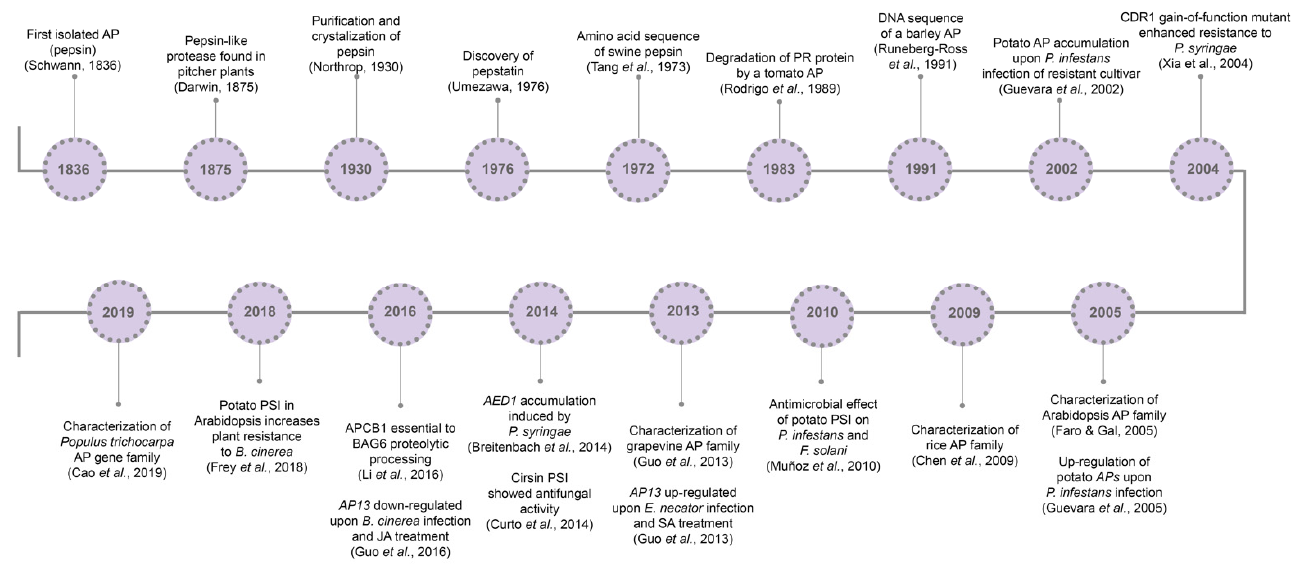
Figure 1. Aspartic proteases historical breakthroughs. AP, aspartic protease; CDR1, constitutive disease resistance 1; PSI, plant-specific insert; AP13, aspartic protease 13; SA, salicylic acid; AED1, apoplastic enhanced disease susceptibility 1; APCB1, aspartyl protease cleaving bcl-2 associated athanogene; BAG6, BCL-2 associated athanogene protein 6; SA, salicylic acid; JA, jasmonic acid; MeJA, methyl jasmonate.